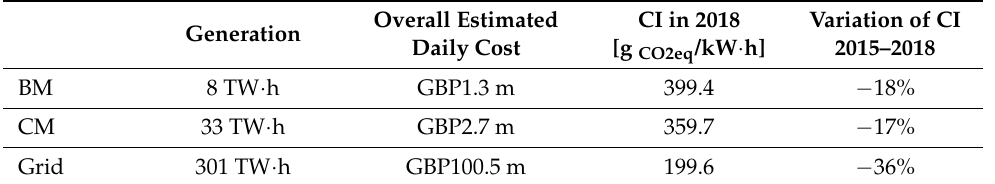
Table 4. Summary of main indicators of economic and carbon costs of balancing services in compari- son with the grid. The variation of CI of the CM refers to the year the auction took